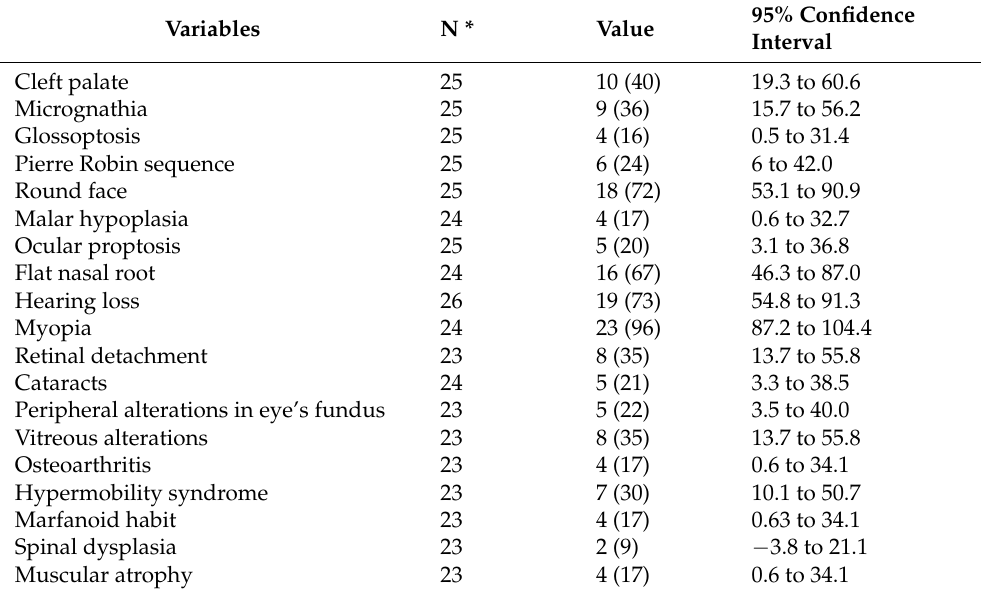
Table 2. Prevalence estimates of Stickler syndrome’s features in children and adolescents of a national patients’ association.